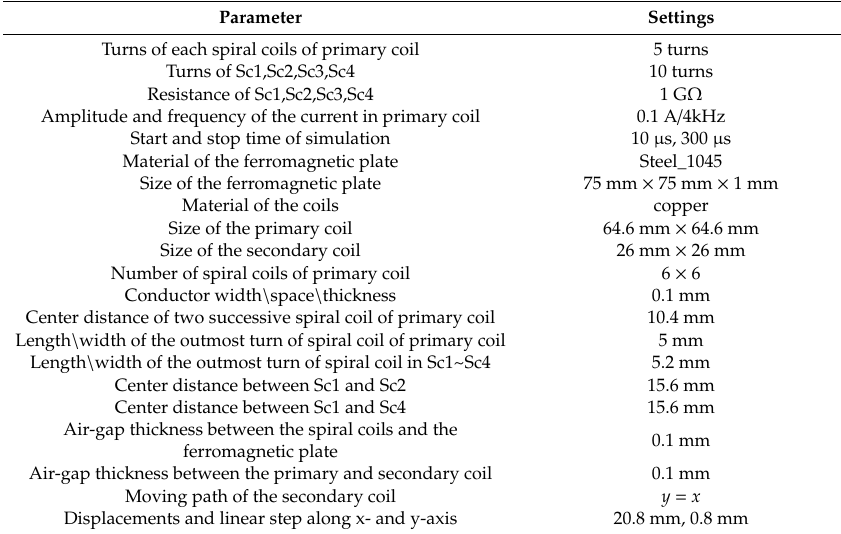
Table 1. Parameters of the sensor